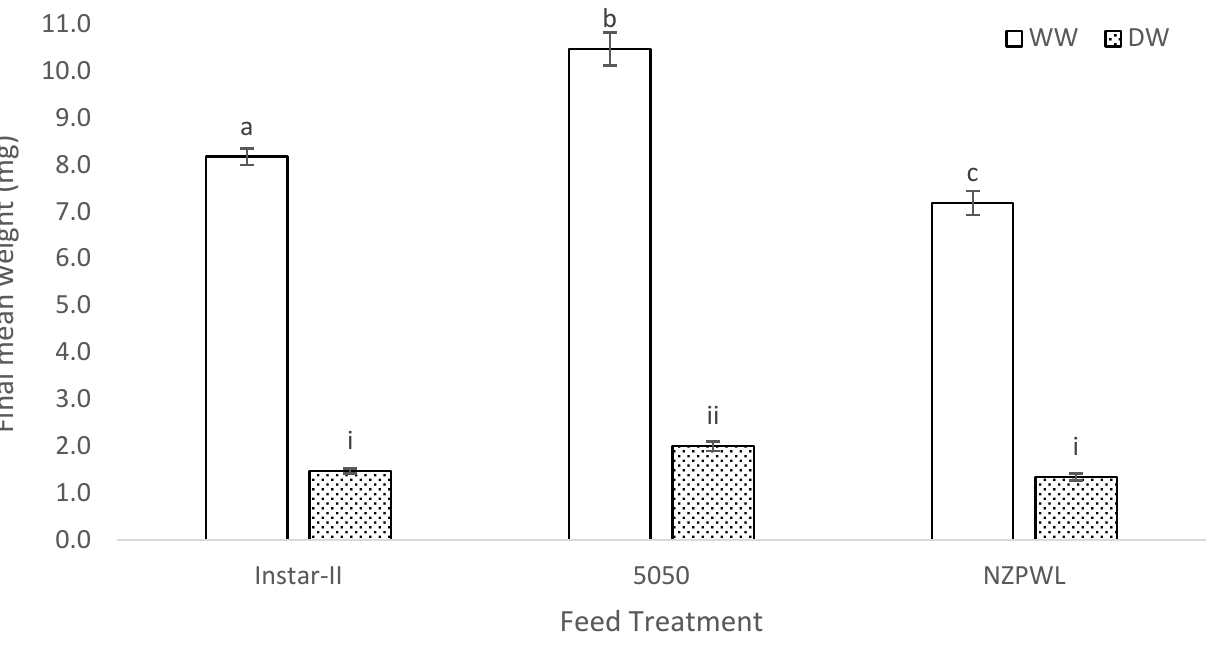
Figure 1. Final mean wet weight (WW) and mean dry weight (DW) for larval giant k ō kopu from three different feed treatments, Instar-II+, 5050, and NZPWL, at the end of a 28-day experimental period (mean ± SE). Means with different superscripts are significantly different for WW or DW ( p < 0.05).